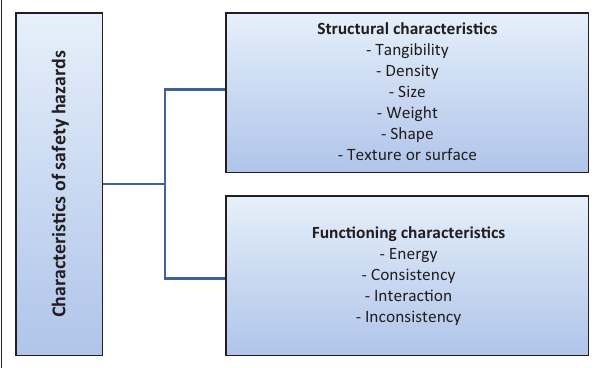
FIGURE 1: Characteristics of safety